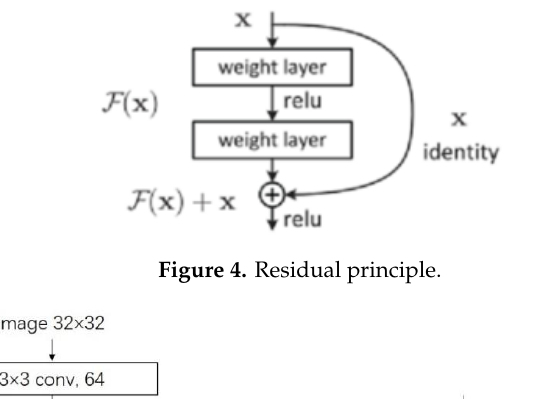
Figure 5. ResNet for transferring.